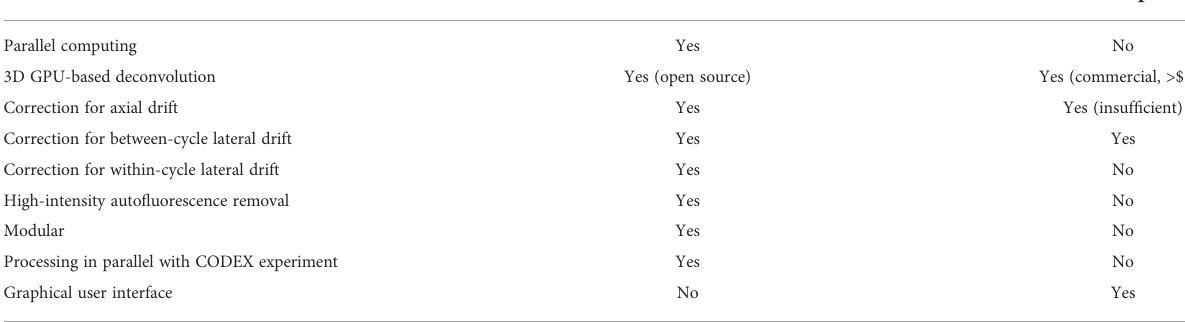
TABLE 1 Comparison between the old and new CODEX image processing pipelines.